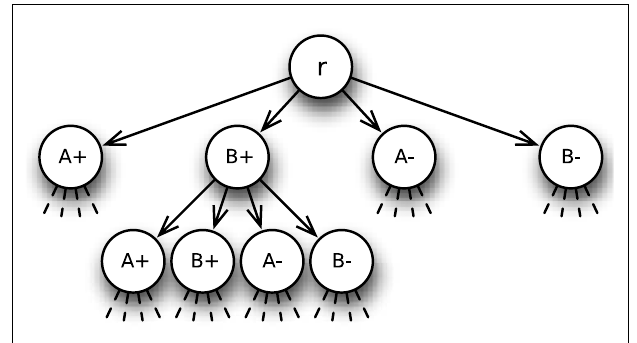
FIGURE 3 |Transition probabilities for the two-alternative choice problem with no counter-dependent and random component. p ( A + ), p ( B ) + , p ( A ) + , and p ( B − ) sum up to one and are the same for the outgoing edges of each vertex v ∈ V